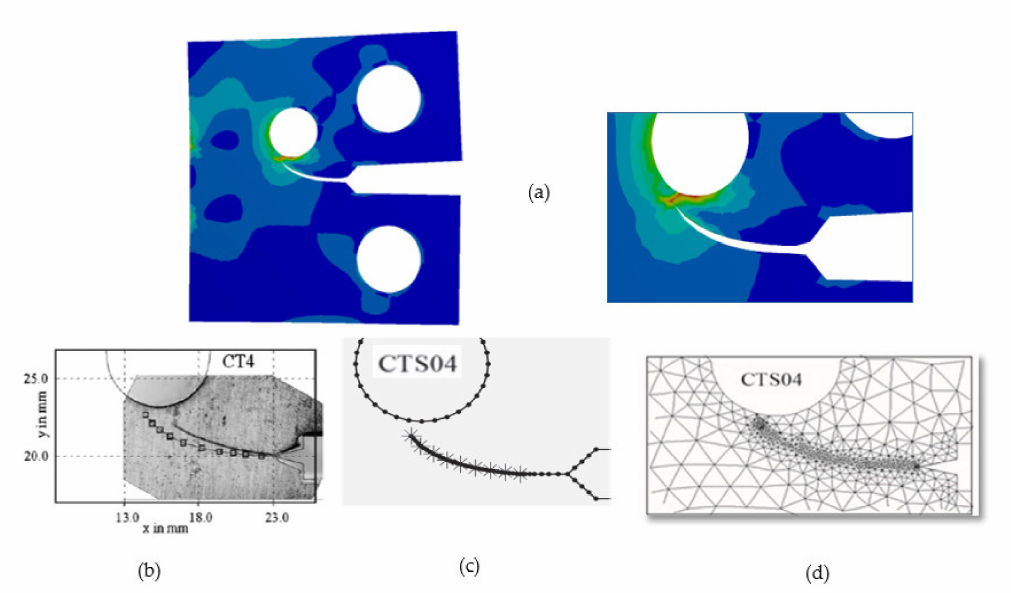
Figure 9. The predicted crack path of CTS04 ( a ) present study, ( b ) experimental and numerical results of [24], ( c ) BemCracker2D [41] and ( d ) Quebra2D